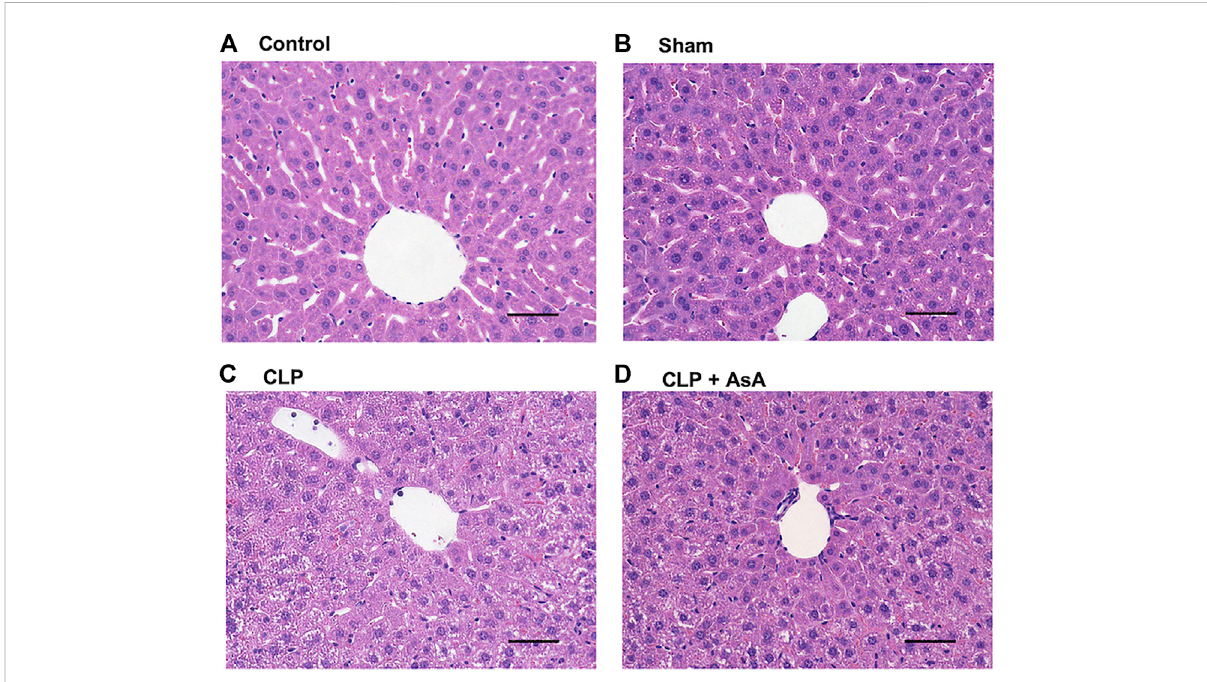
FIGURE 5 Histopathological examination of the liver of CLP-treated and untreated mice. (A,B) Normal histology of liver tissues obtained from sham and control mice. (C) Representative CLP-induced liver damage. (D) Representative liver of CLP mice treated with early AsA administration. Sham and CLP mice were killed 12 h after the operation. Original magni fi cation, ×40. Abbreviations: AsA, ascorbic acid; CLP, cecal ligation and